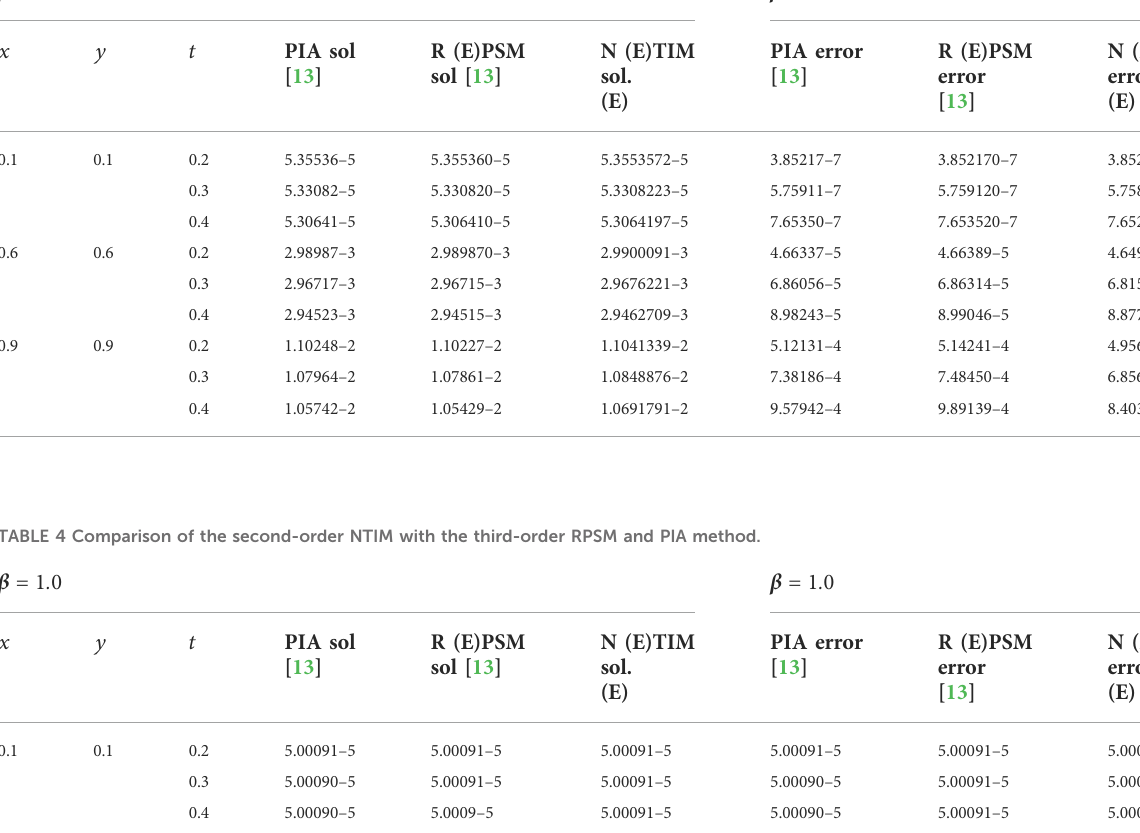
TABLE 3 Comparison of the second-order NTIM with the third-order RPSM and PIA method. β (cid:2) 1 .